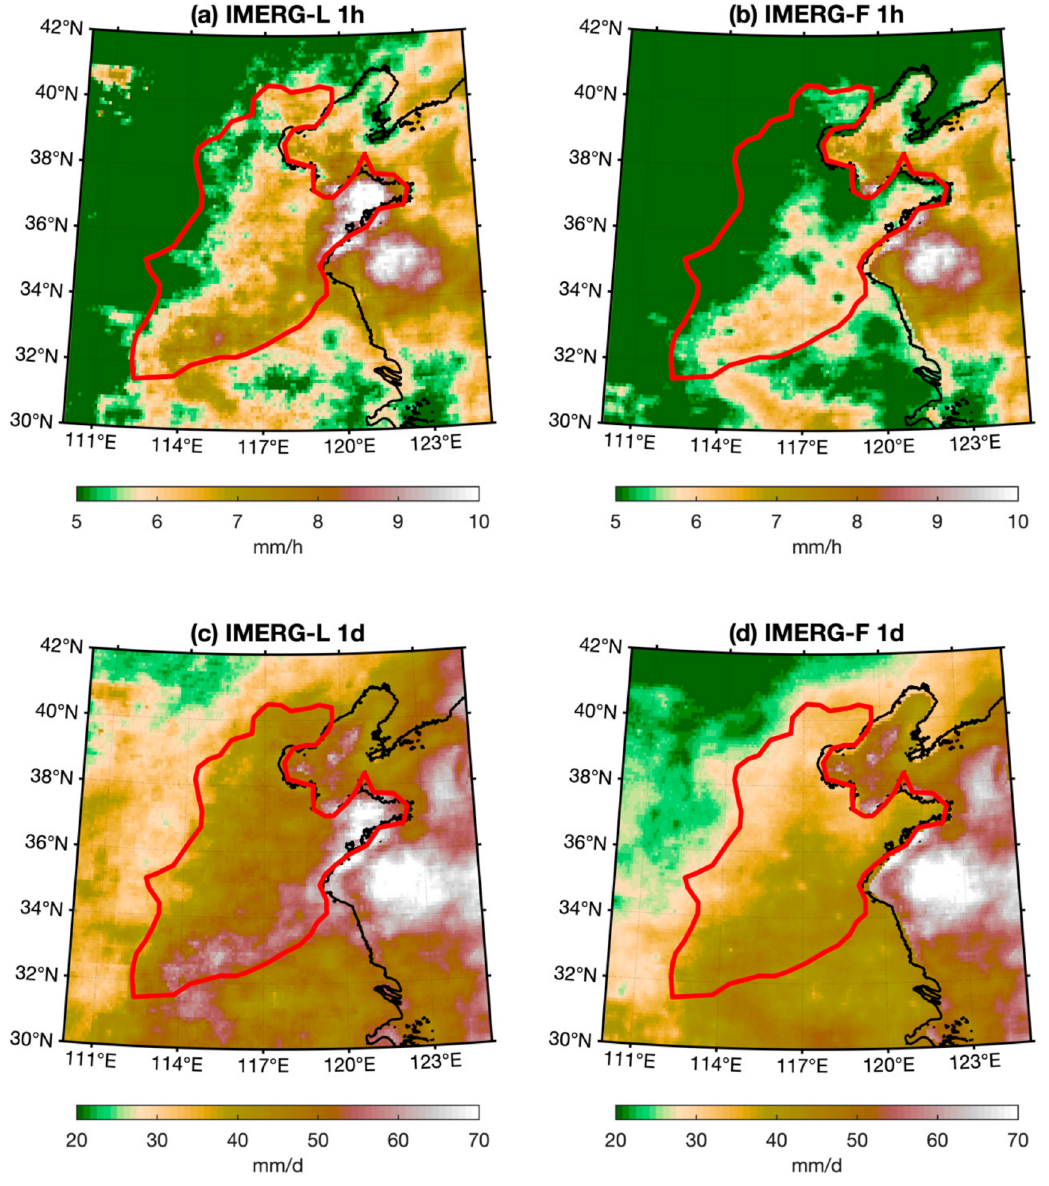
Figure 8. Threshold for extracting hourly ( a , b ) and daily ( c , d ) extreme precipitation events from 2000 to